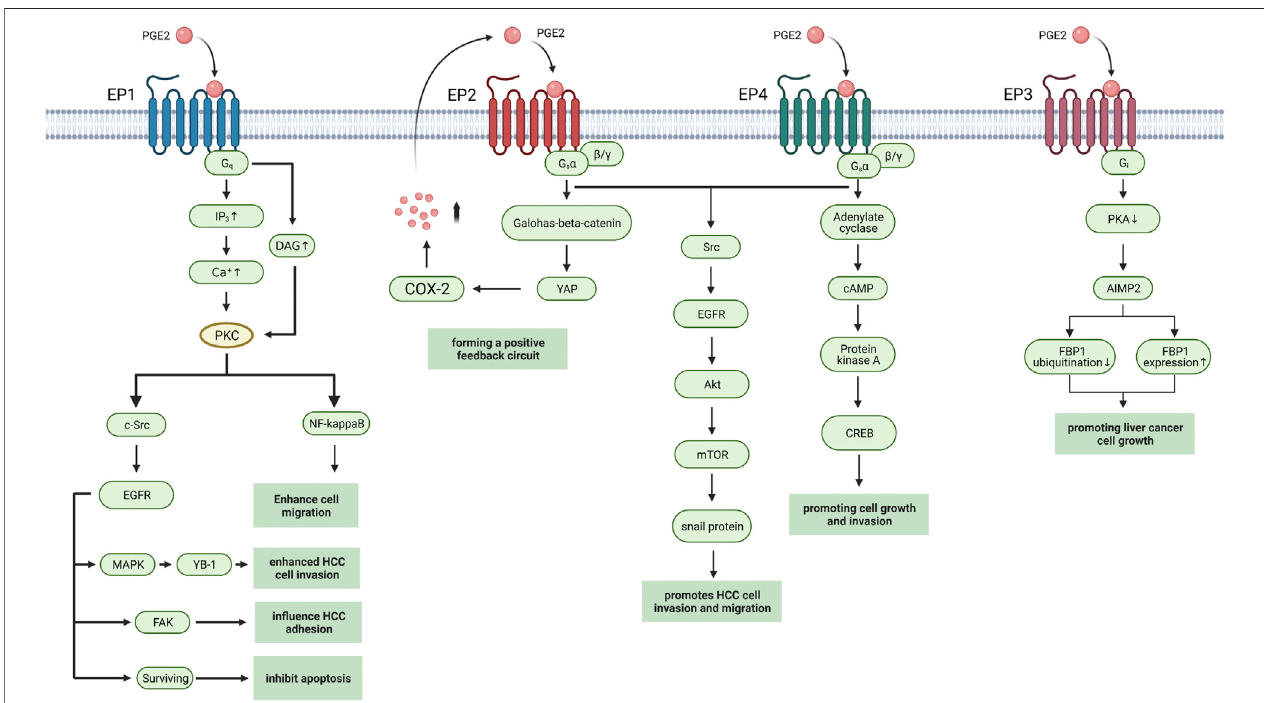
FIGURE 2 | EP receptors in HCC. The EP receptors with downstream pathways in HCC are shown. Created with BioRender.com. YB-1, Y box-binding protein 1; FAK, Focal adhesion kinase; YAP, Yes-associated protein; AIMP2, aminoacyl-tRNA synthetase interacting multifunctional protein 2, also known as JTV1; FBP1, FUSE- binding protein 1.